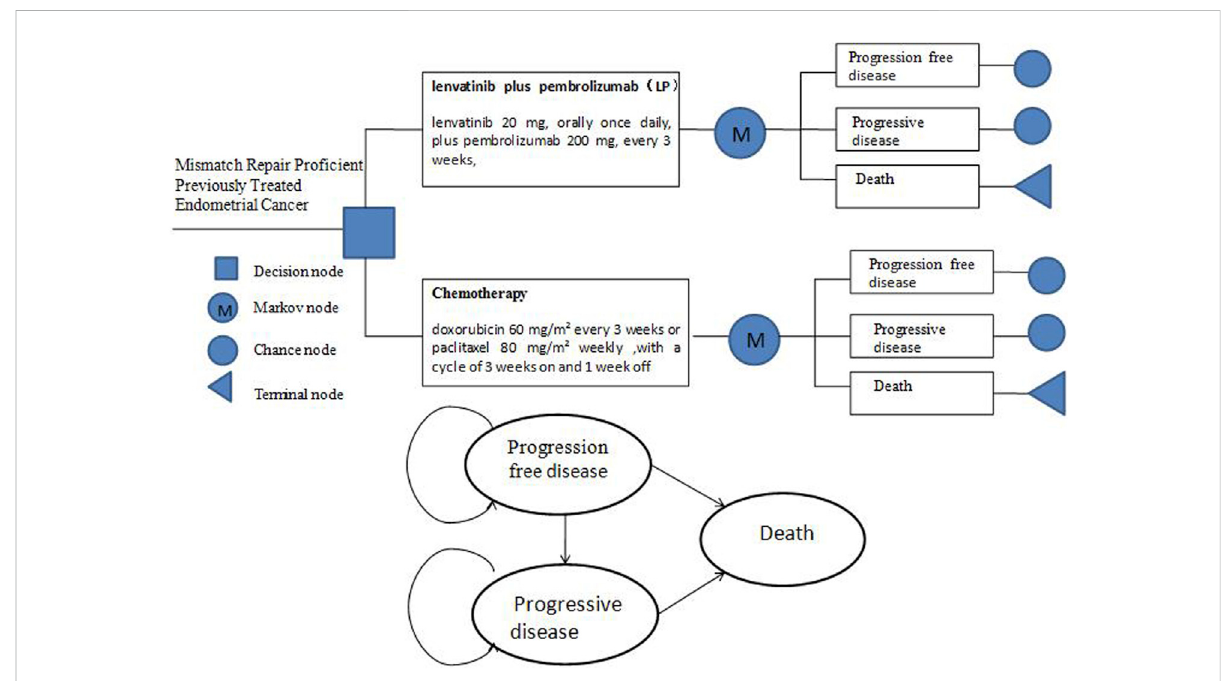
FIGURE 1 Markov Structure of three health states: progression-free disease, progressive disease and